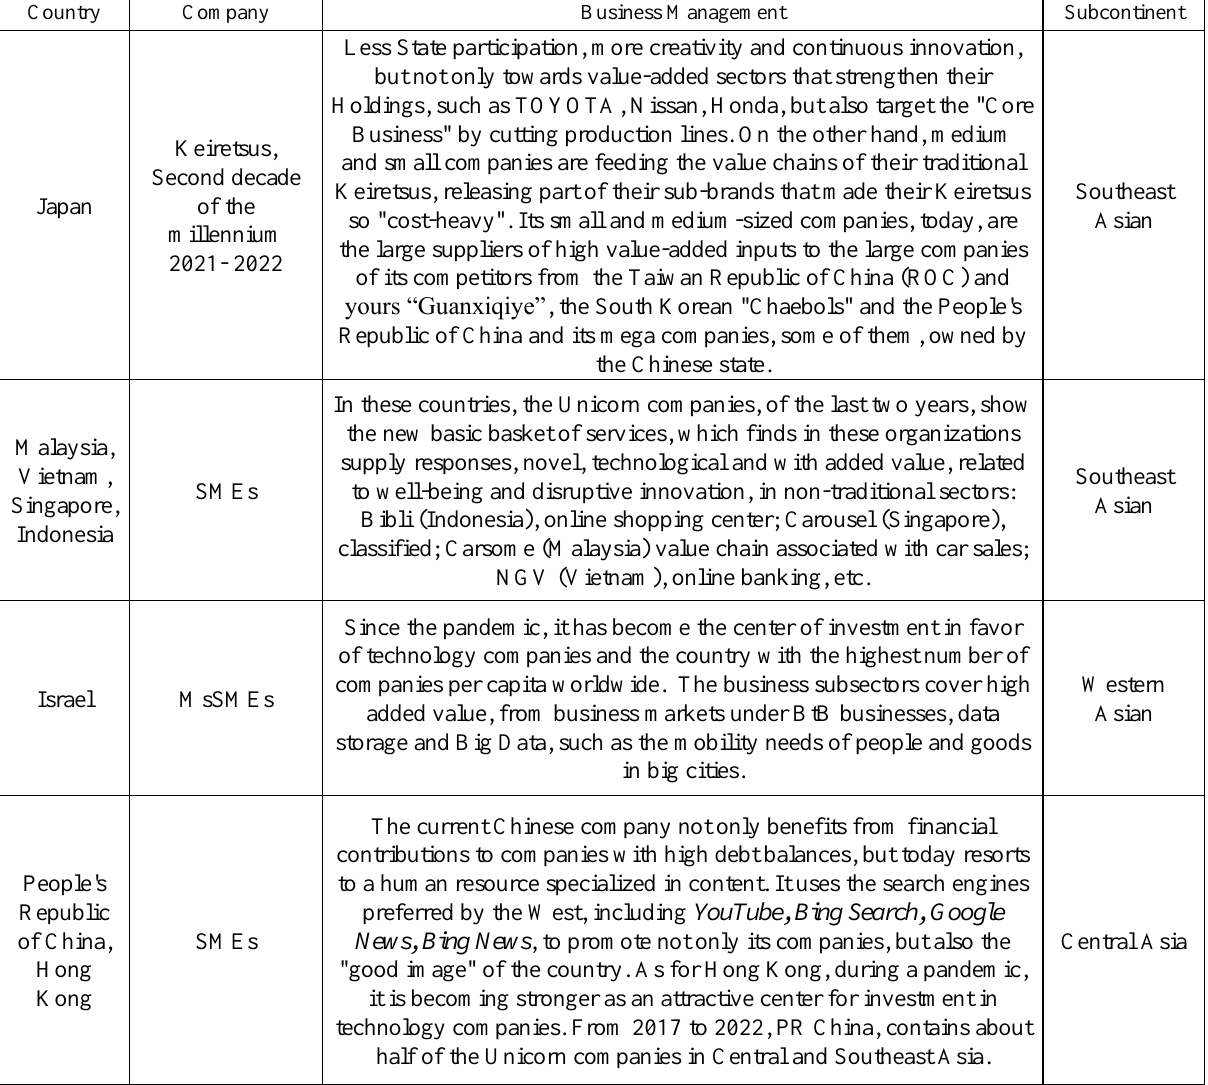
Table 2. Characteristics of post pandemic